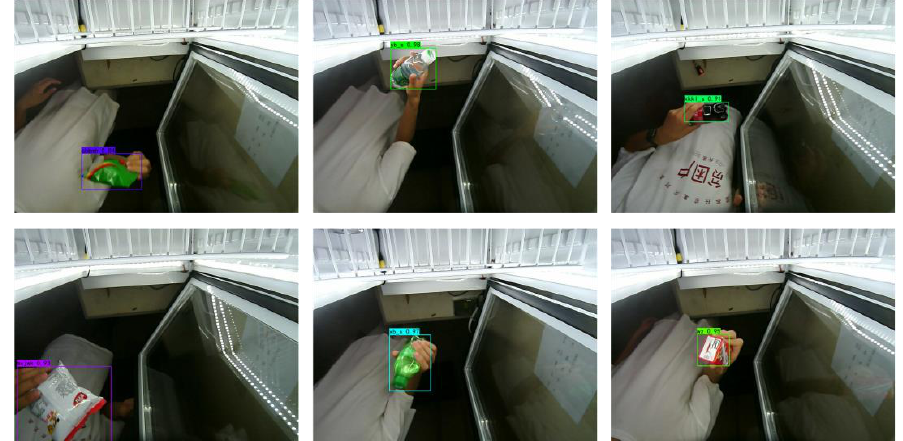
Figure 16. Detection results for different types of small commodities.